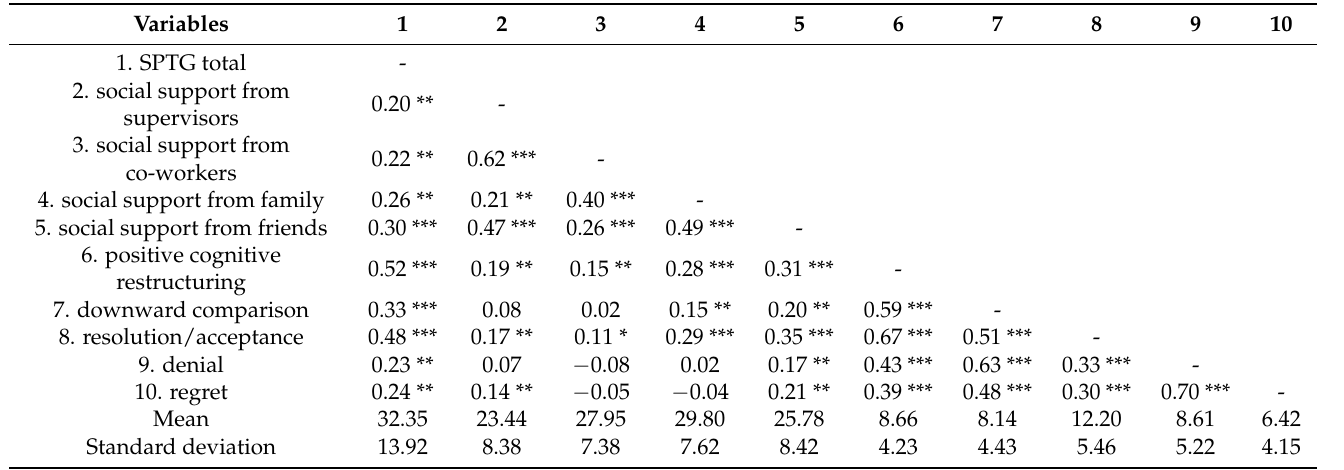
Table 1. Correlation coefficients, mean, and standard deviations ( N =